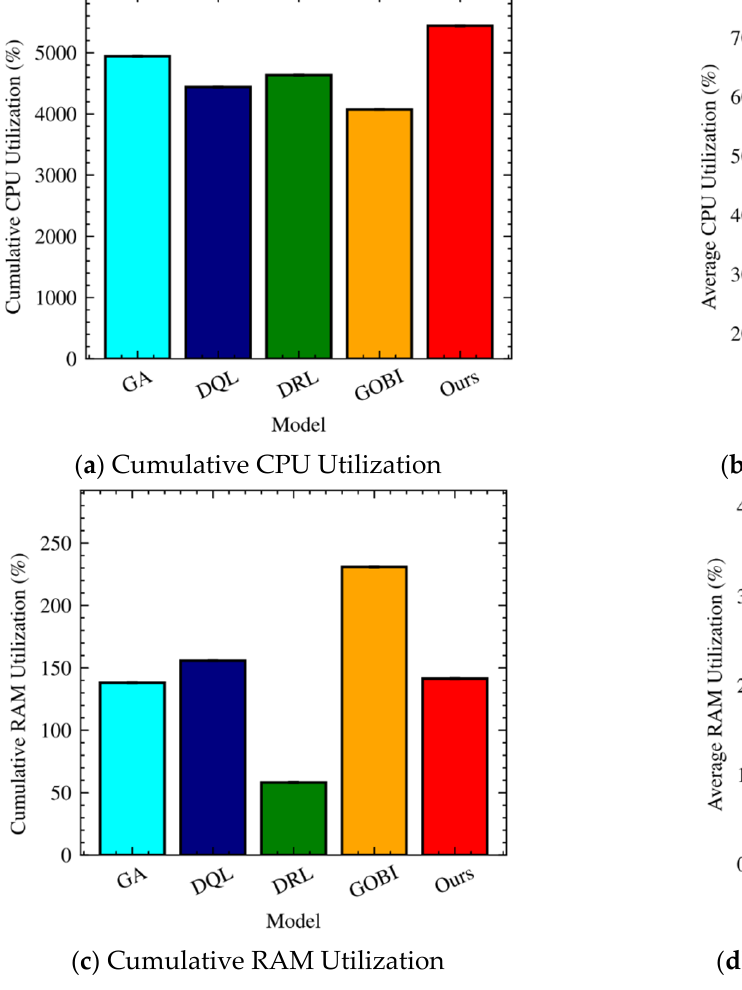
Figure 3. CPU and RAM utilization with ten hosts.